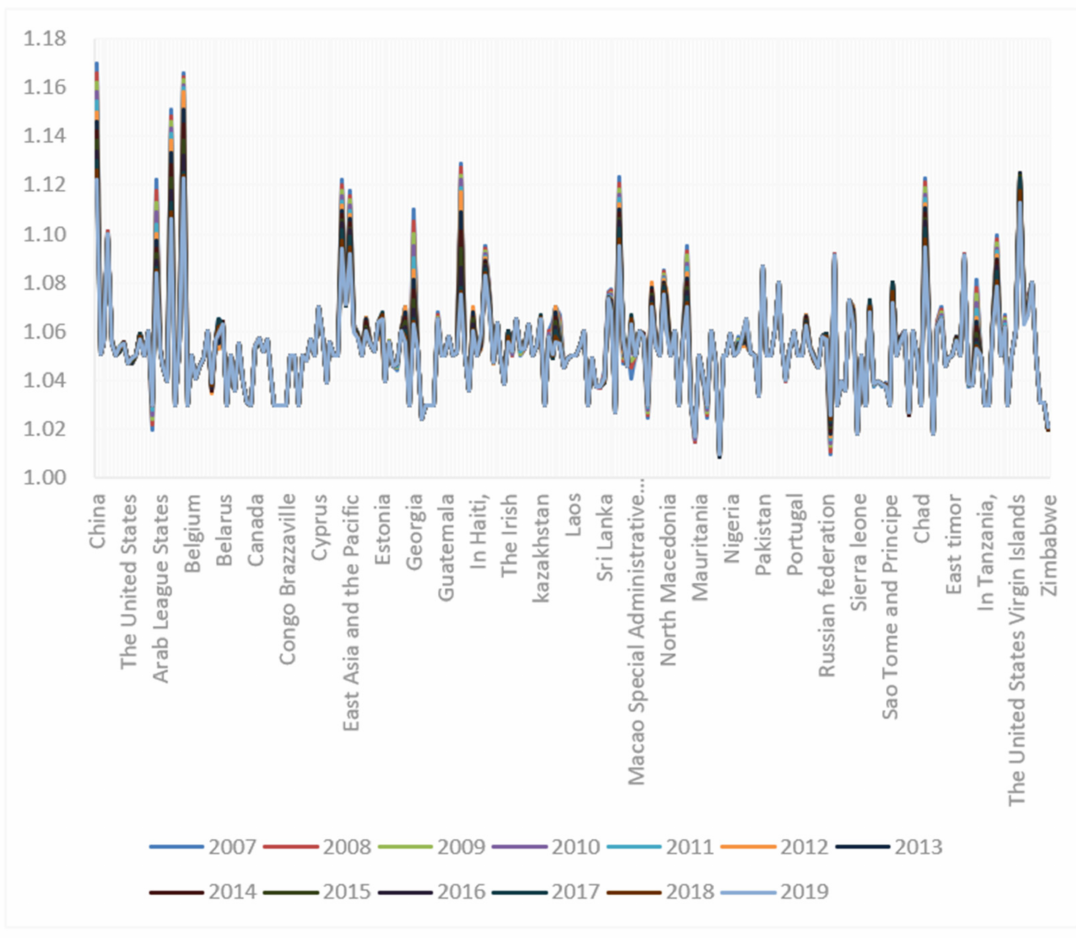
Figure 3. Gender ratio of population at birth by country, 2007–2019